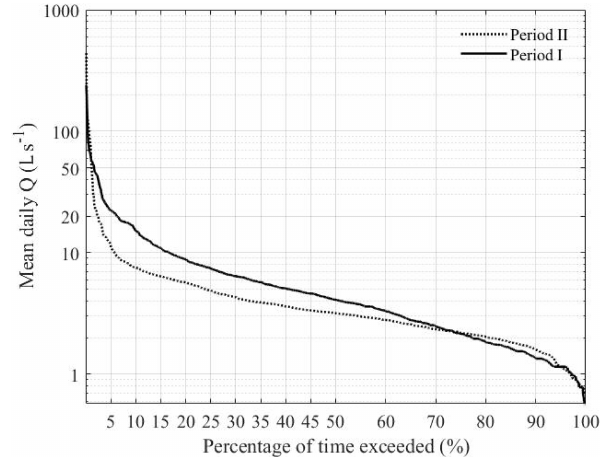
Figure 4. Mean daily flow duration curve for periods I (solid line) and II (dashed